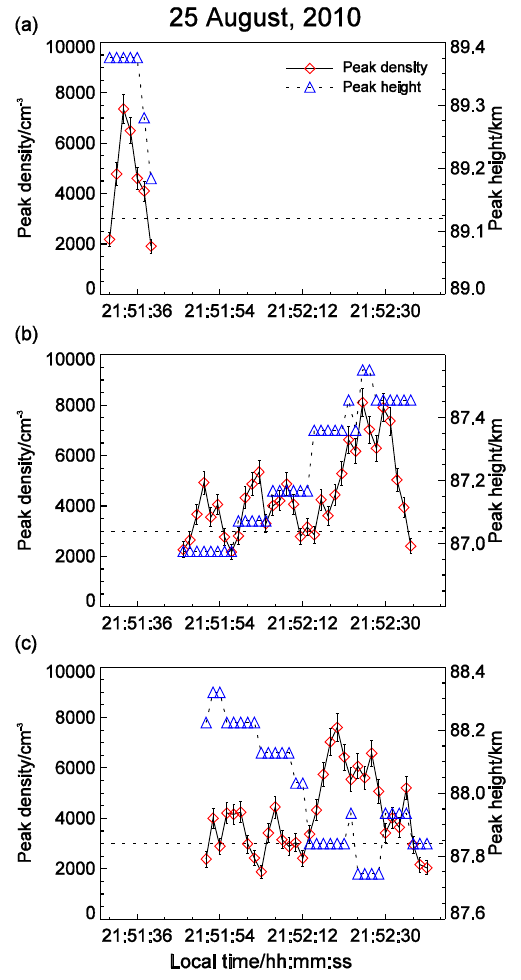
Fig. 12. The peak height and peak density variations of meteor trails corresponding to each branch of the Na s layer in Fig.